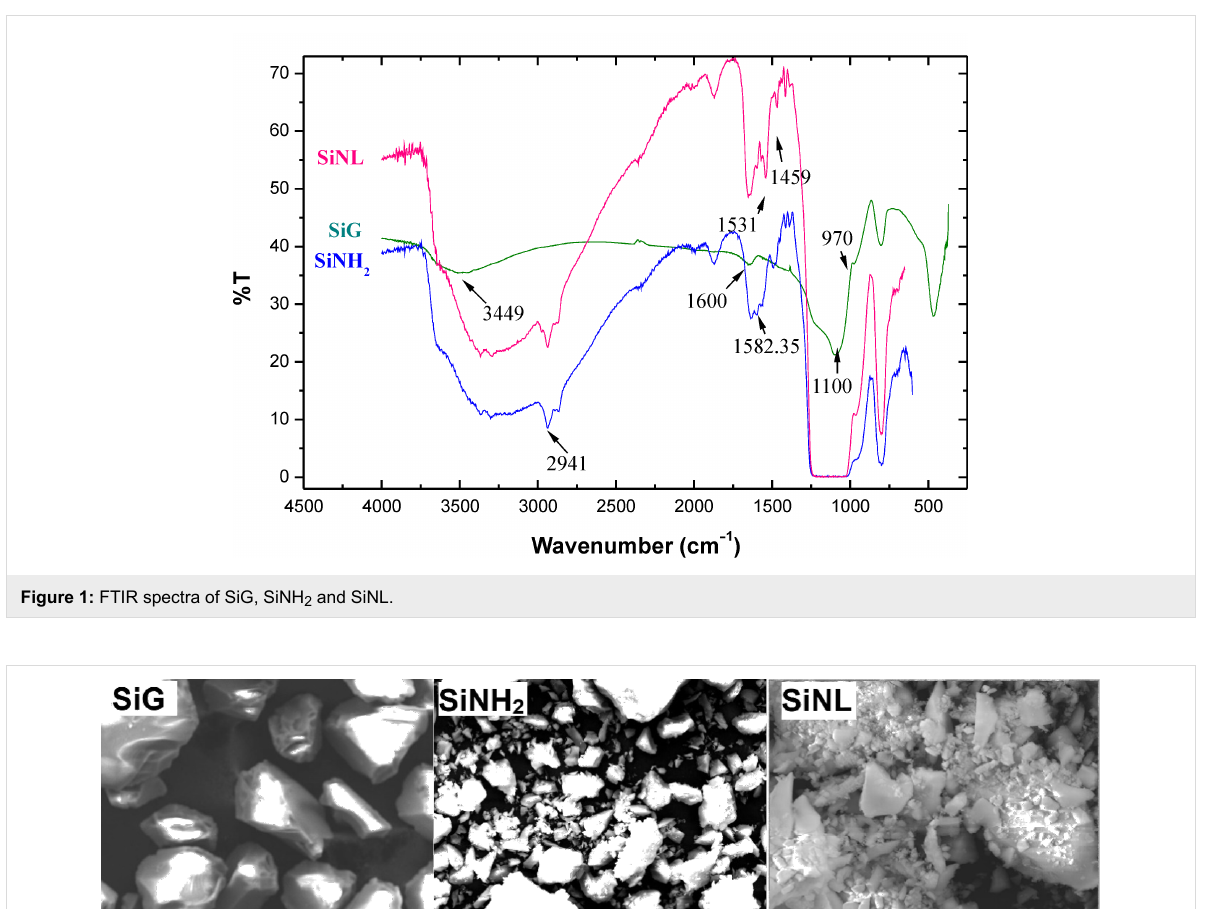
Figure 2: SEM images of free silica (SiG), SiNH 2 and